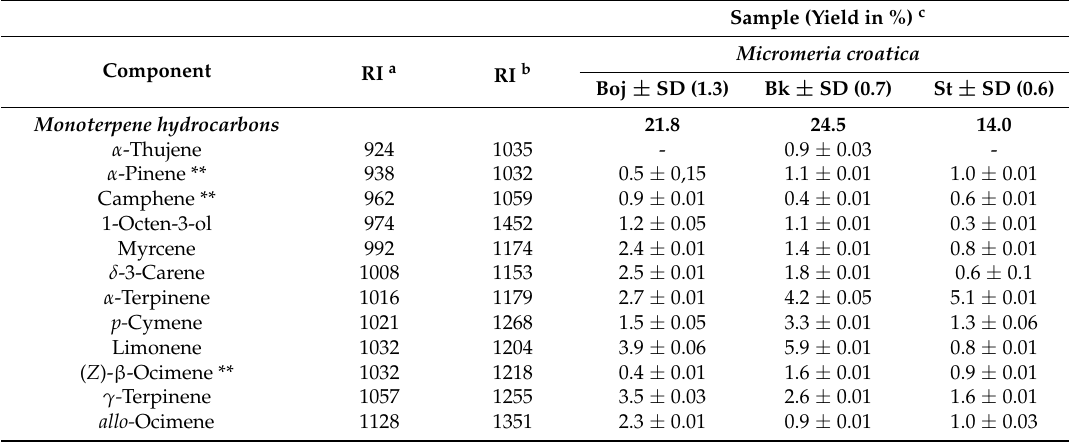
Table 1. Phytochemical composition (%), identification and major groups of chemical components of the essential oil of Micromeria croatica (Pers.) Schott from the localities Bojinac (Boj), Baˇci´c kuk (Bk) and Stupaˇcinovo (St)